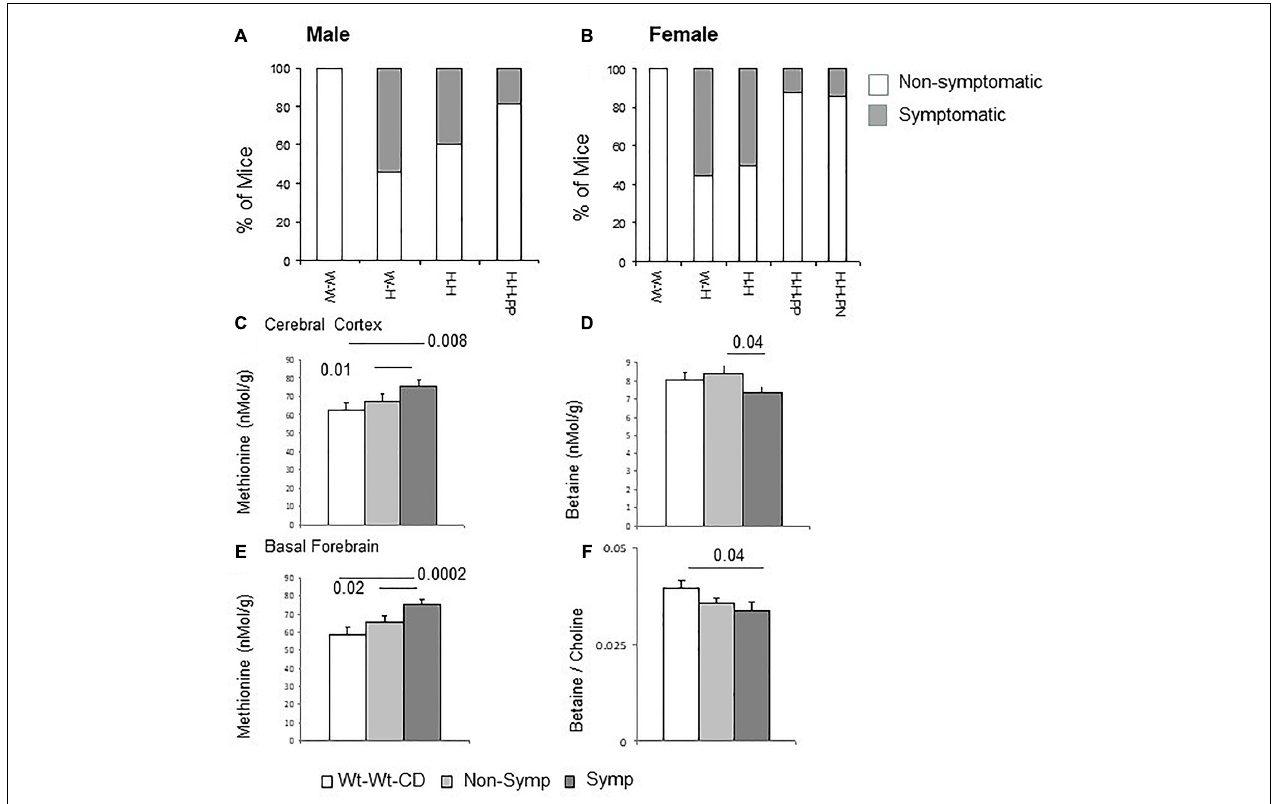
FIGURE 1 | ASD-like behavior – proportion of symptomatic male (A) and female (B) mice among experimental groups. C1 metabolism levels categorized by phenotype (Male + Female) in the cerebral cortex for methionine (C) and betaine (D) and in the basal forebrain for methionine (E) and for betaine/choline ratio (F) . N = Wt-Wt-CD, 28; Non-Symptomatic, 78; Symptomatic, 21. (A,B) Wt-Wt-CD (W-W); Wt-Het-CD (W-H); Het-Het-CD (H-H); Het-Het-PP (H-H-PP); Het-Het-PN (H-H-PN). N, as detailed in Table 1 . Because the small group size of male Het-Het-PN (group 5, n = 3) precluded statistical analysis and extraction of the percent of symptomatic mice, the data for these mice were excluded from the figures. Data are presented as means ± SEM. P -value refers to the difference compared to Wt-Wt-CD